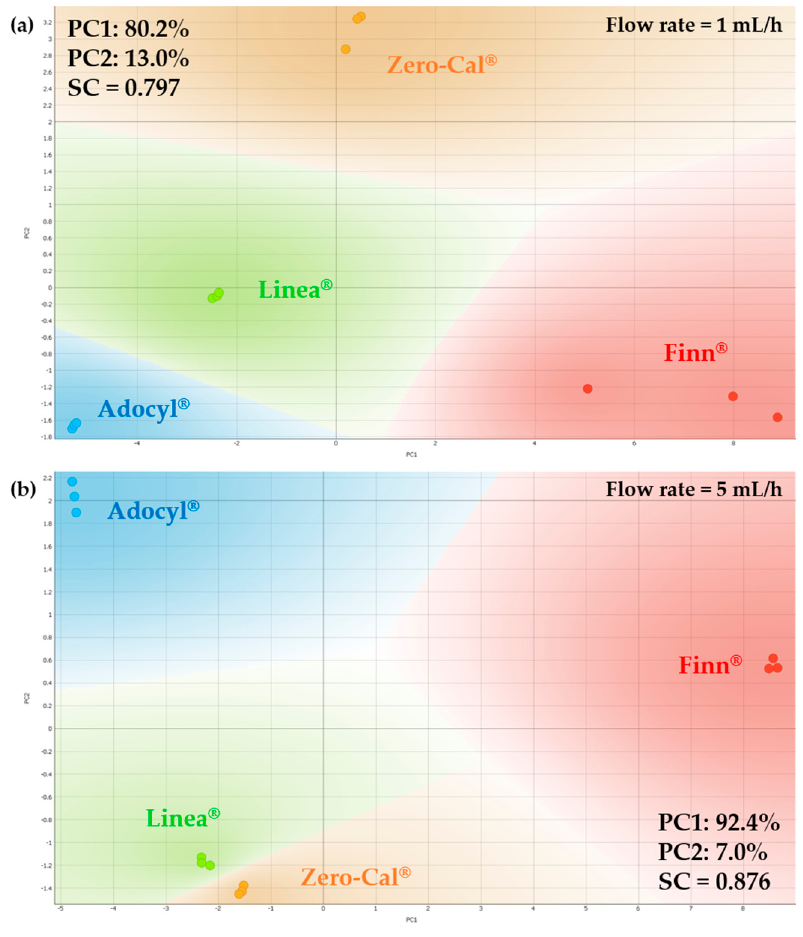
Figure 8. PCA plots for distinct brands of sucralose-based sweeteners in aqueous solutions (10 µL/mL) obtained using the impedimetric microfluidic e-tongue under ( a ) 1 mL/h and ( b ) 5 mL/h flow rates. Sensors 2020 , 20 , x FOR PEER REVIEW